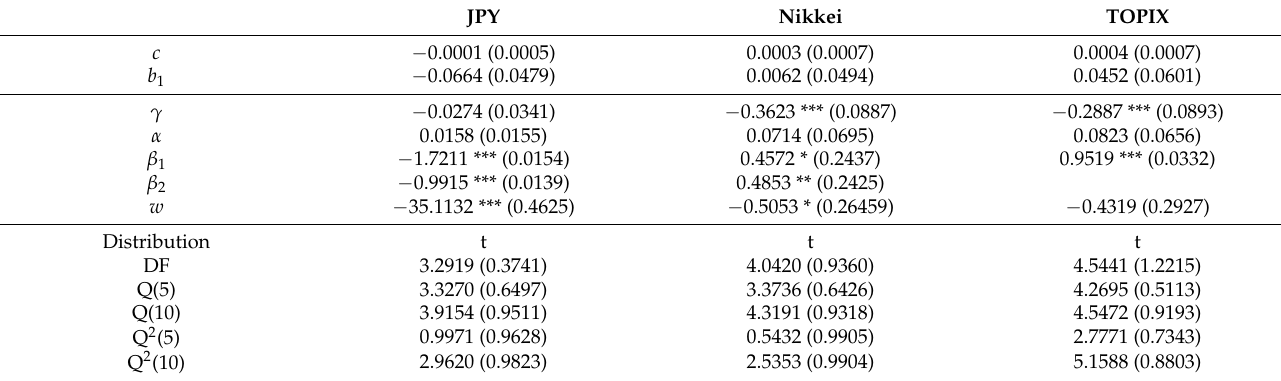
Table 2. EGARCH estimation for JPY, Nikkei, and TOPIX. Author’s estimations based on data from the Bank of Japan, TSE, and Yahoo Finance. The numbers in parentheses are standard errors. ***, **, and * indicate significance at the 1%, 5%, and 10% levels, respectively. Distribution is Student’s t. DF means the degree of freedom. Q (5) and Q (10) (and squared Q (5) and Q (10)) are the Ljung–Box Q statistics for the null hypothesis of no autocorrelation of up to orders 5 and 10 for the standardised residuals (and squared standardised residuals).